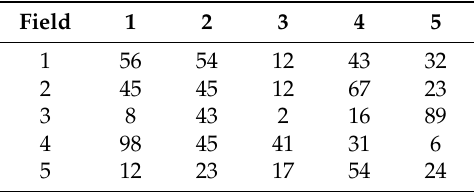
Table 4. Distance from fields to collection centers (km).